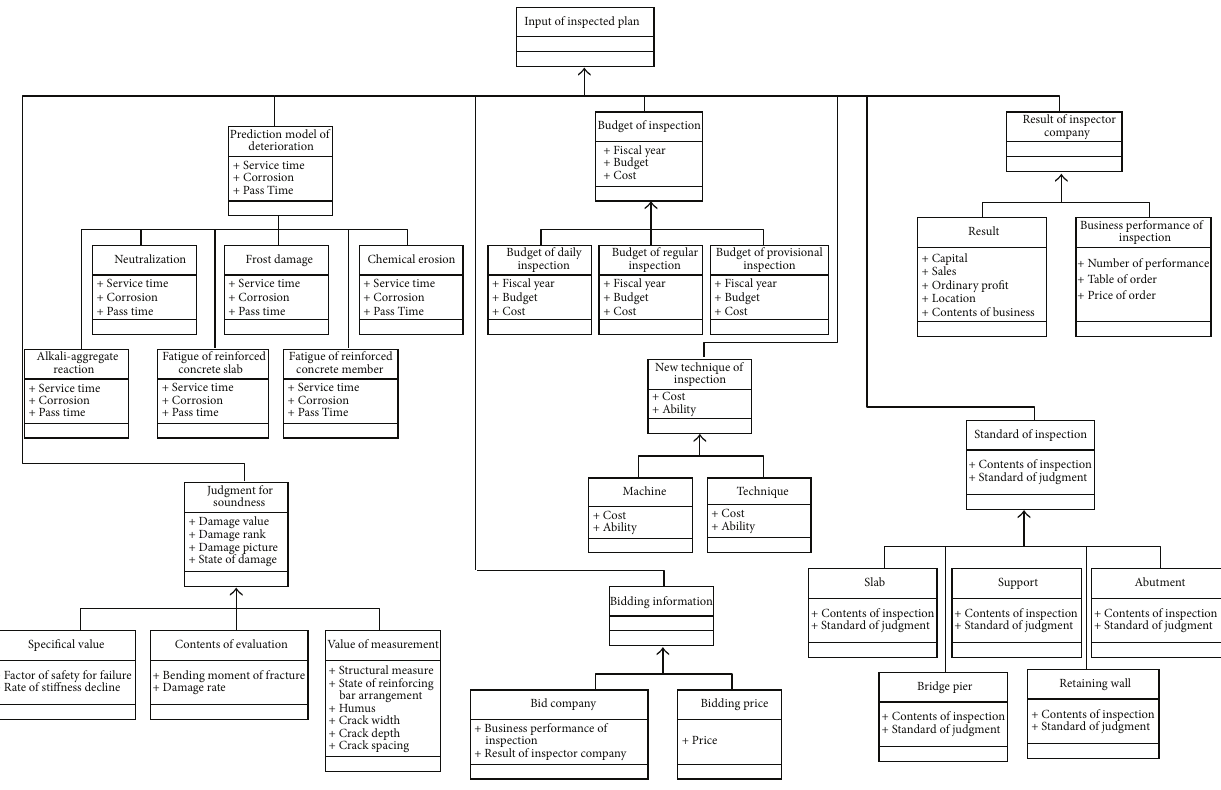
Figure 5: Data model of inspection